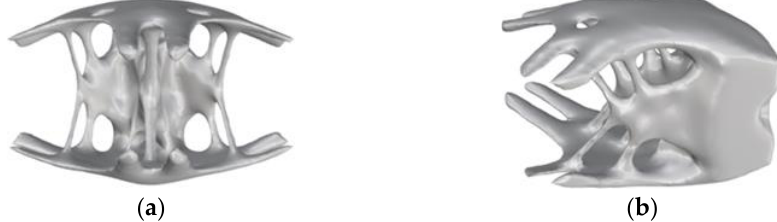
Figure 18. Smooth model of different angles under shear conditions: ( a ) front; ( b ) side.